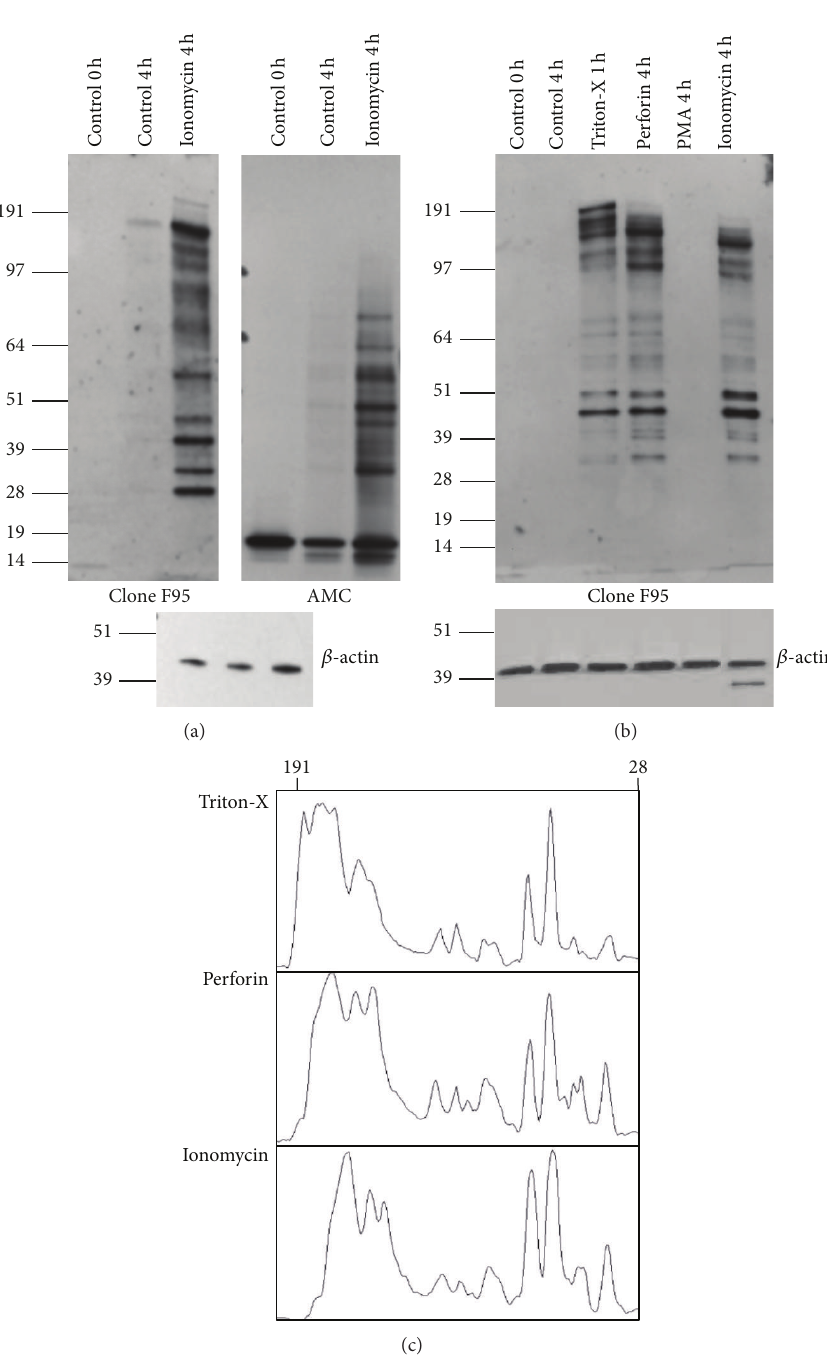
Figure 1: Neutrophil hypercitrullination can be induced by cell membrane lytic conditions. (a) Freshly isolated neutrophils cultured in medium with 2 mM CaCl 2 alone or in presence of 1 𝜇 M ionomycin for 1 or 4 hours. Citrullinated proteins were detected by anti-citrulline antibody clone F95 (left panel) or anti-modified citrulline antibody (AMC) (right panel). Lower panel, immunoblot of the same filter with anti- 𝛽 -actinasaloadingcontrol.(b)Freshlyisolatedneutrophilsculturedinmediumwith2mMCaCl 2 aloneorwith1 𝜇 Mionomycin,0.005% Triton-X, or 500 ng/mL perforin for 4 hours and immunoblotted with clone F95 antibody. Lower panel, immunoblot with anti- 𝛽 -actin as a loading control. Similar results were obtained with neutrophils from four additional donors. (c) Densitometric scan of lanes 3, 4, and 6 of the blot in panel